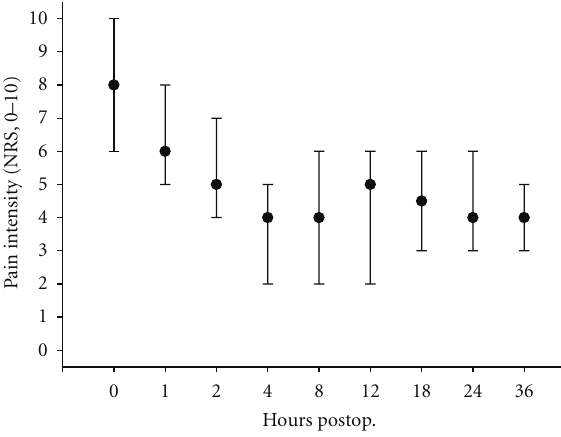
Figure 2: Intensity of pain during coughing. Intensity of pain was assessed on a numerical rating scale (0–10) 0, 1, 2, 4, 8, 12, 18, 24, 36hr after end of surgery. Data are expressed as median (interquartile range). n = 15 ( n = 11 and n = 14 after 12 and 18hr,